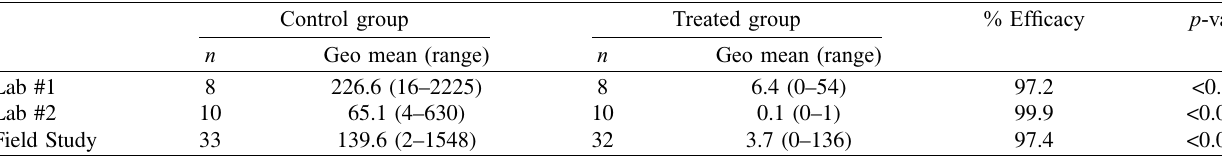
Table 3. Ear mite counts following ear canal fl ushing in Lab #1, Lab #2 and the Field study, one month after treatment.